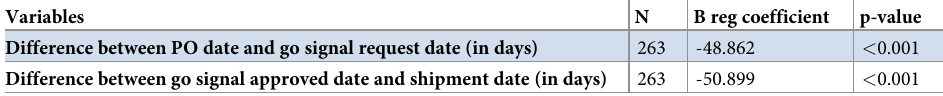
Table 3. Bivariate association between regression results showing the relationship between implementation of information sharing through NTDeliver and key differences between go signal dates. Variables